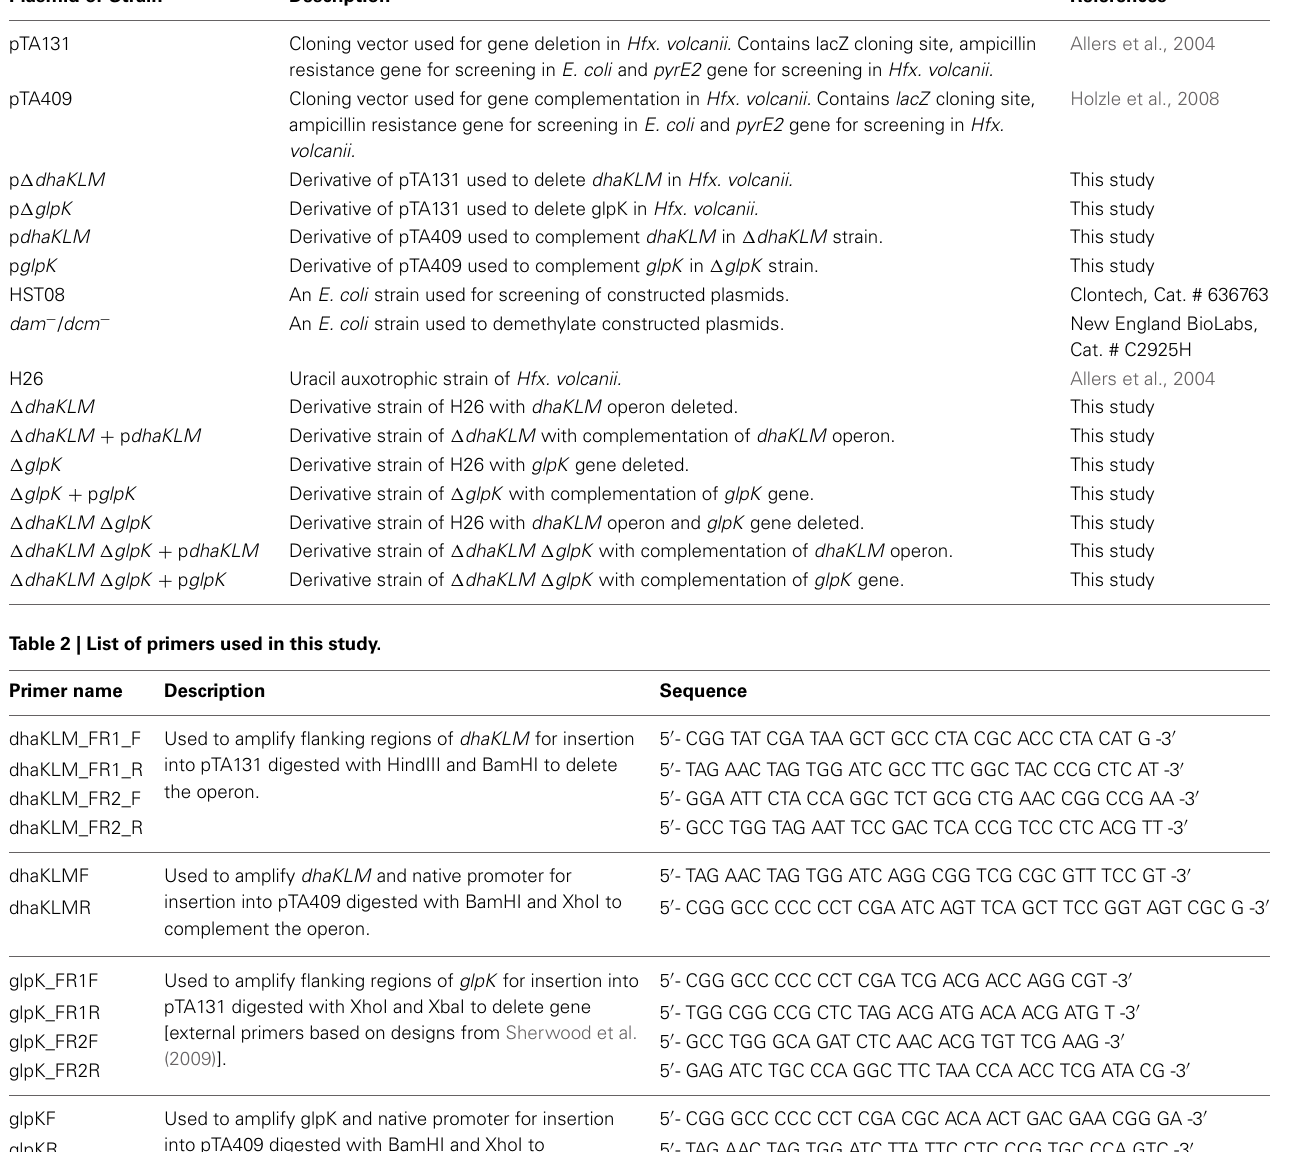
Table 1 | List of plasmids and strains used in this study. Plasmid or Strain Description